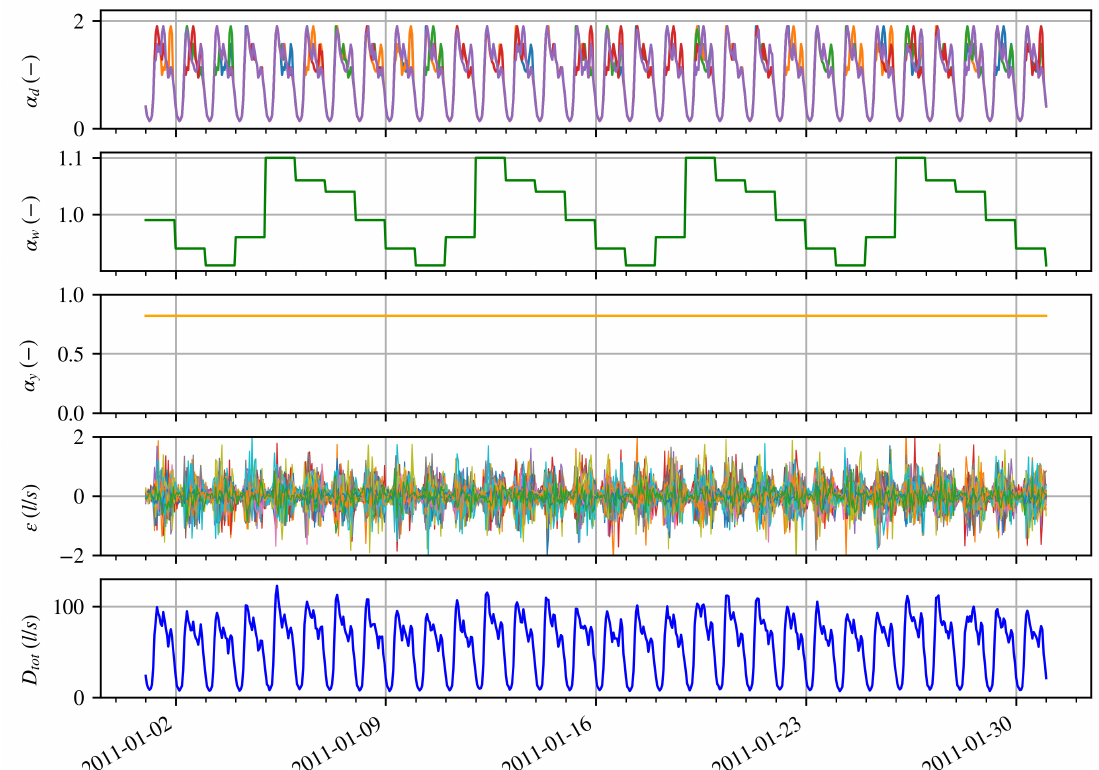
Figure 3. Water request components of the Apulian test case. Starting from the top, the first plot represents the daily pattern, the second the weekly pattern, and the third the yearly pattern. The fourth plot represents the random component and the fifth the resulting water